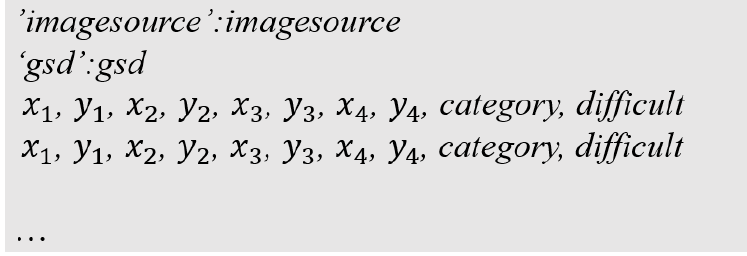
Figure 5. Annotation information of the dataset.